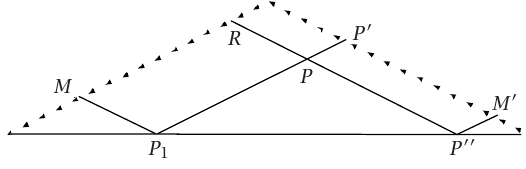
Figure 3.1 . The regions in the definition of G(P ; x,t)